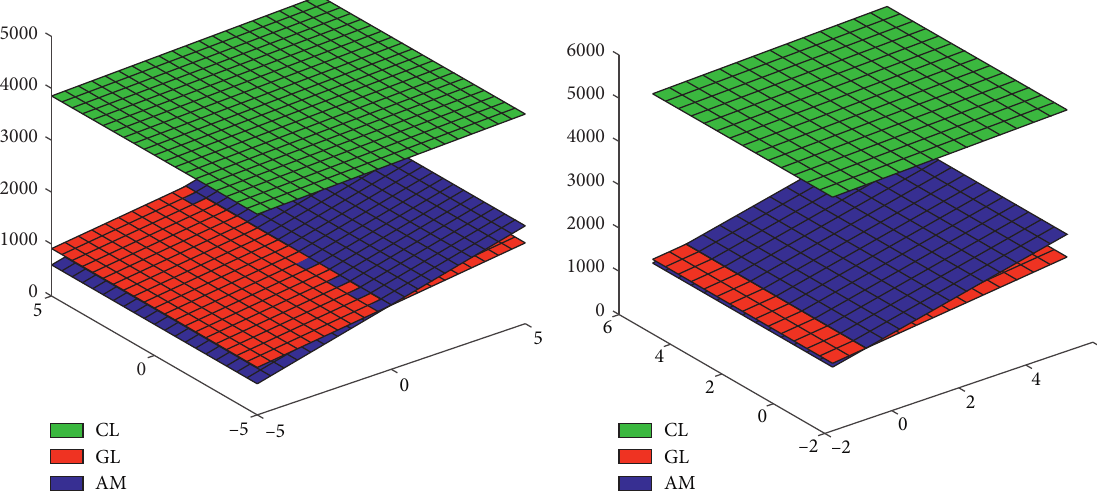
Figure 11: Comparison of CL l